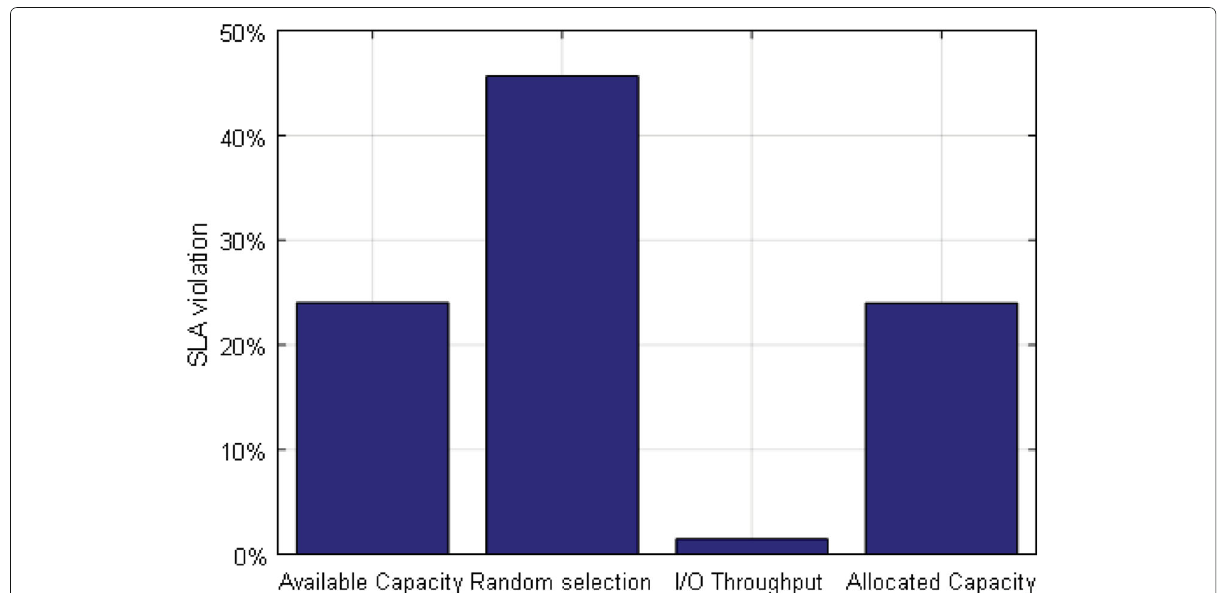
Fig. 4 Different violation rates in available space filtering strategies